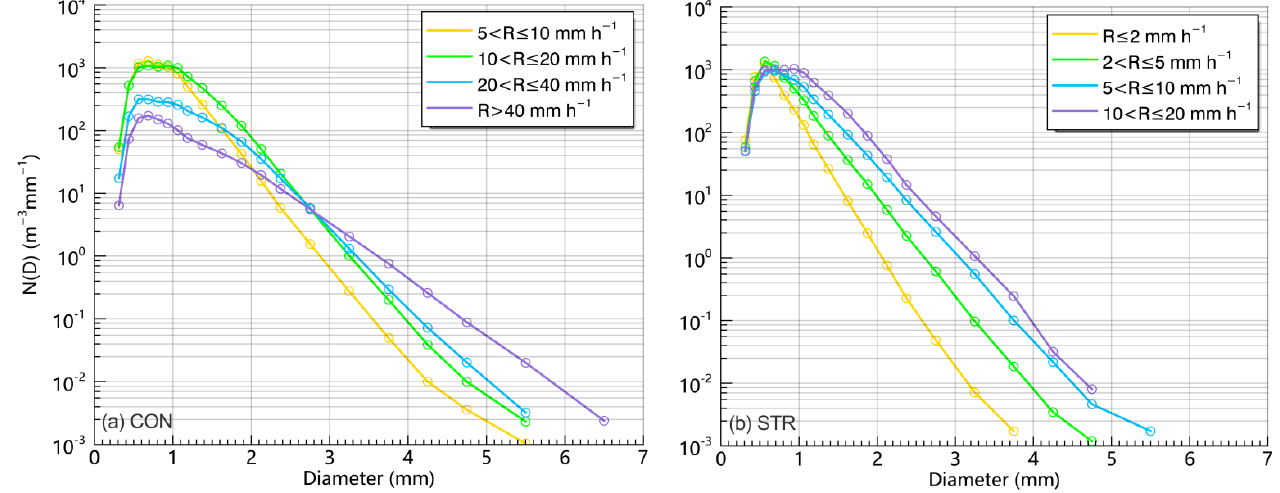
Figure 5. The composite raindrop spectrum from the PARSIVEL disdrometer data at different rain rates for ( a ) convective rain and ( b ) stratiform rain.